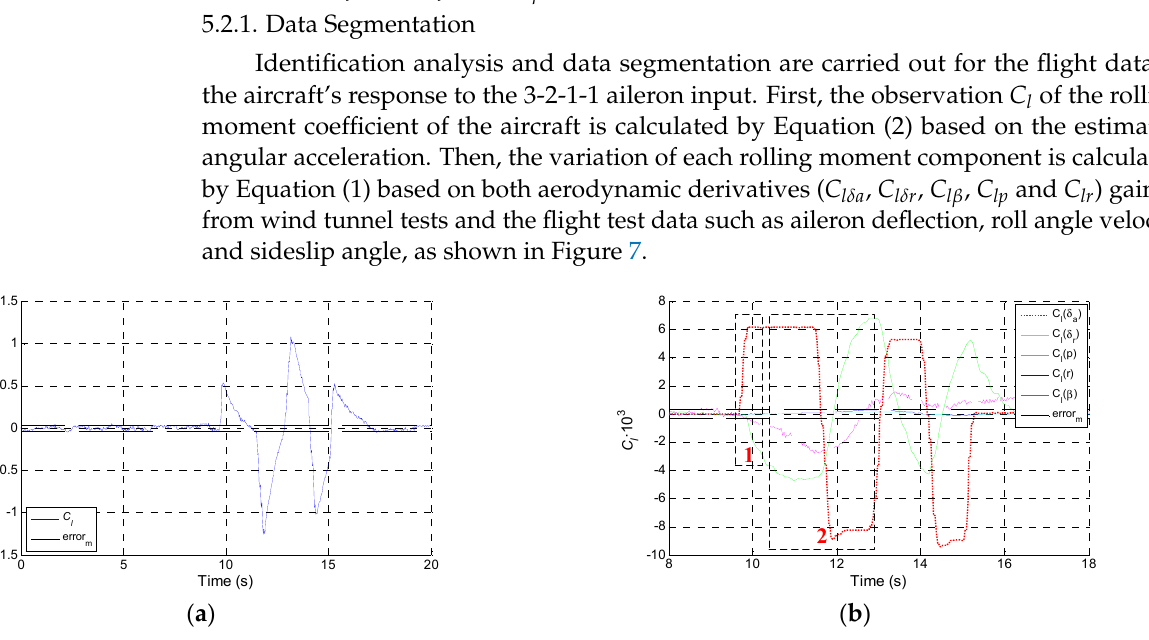
Figure 7. Identifiability analysis of rolling moment coefficient and data segmentation in aileron 3-2-1-1 input. ( a ) Variation of rolling moment coefficient; ( b ) Variation of rolling moment components.